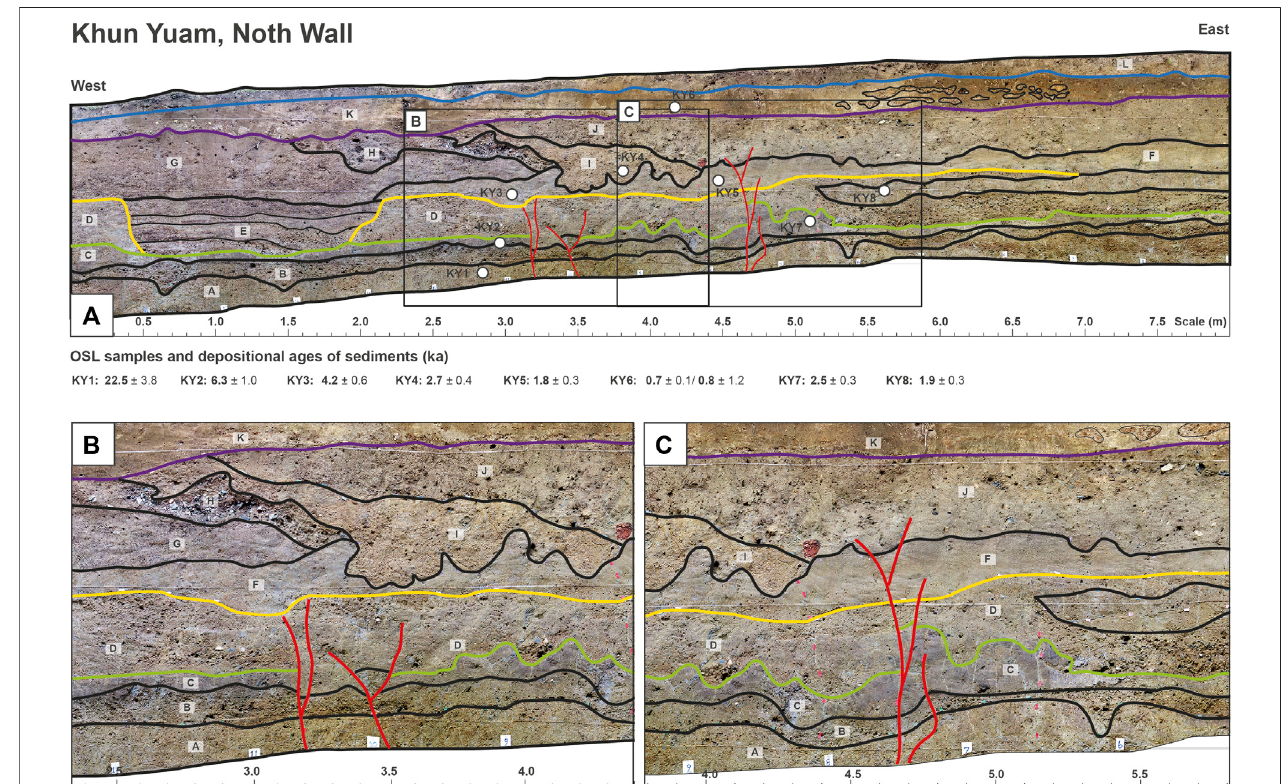
FIGURE 7 | Sections and wall logs on the north wall at Khun Yuam trench showing sediment stratigraphy, fault orientation, sample locations for dating, and OSL ages(inka)ofsedimentlayers.Thetrenchlocationisshownin Figure5B . (A) NorthwallofKhunYuamtrench (B) and (C) closed-upphotographsshowingdiscontinuity of sediment layer and fault traces (red line) were observed in the wall.